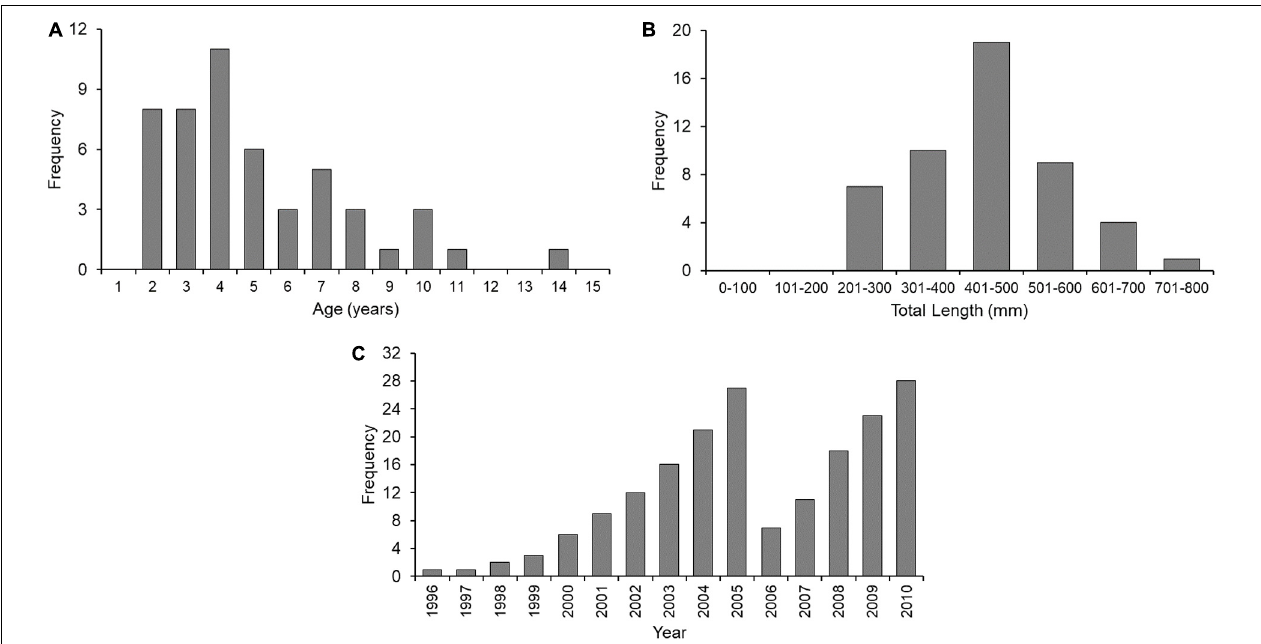
FIGURE 2 | Absolute frequency plots of (A) age (in years), (B) total length (in mm), and (C) increment measurements (per year), of Port Jackson shark samples examined in this study ( n = 50 sharks).